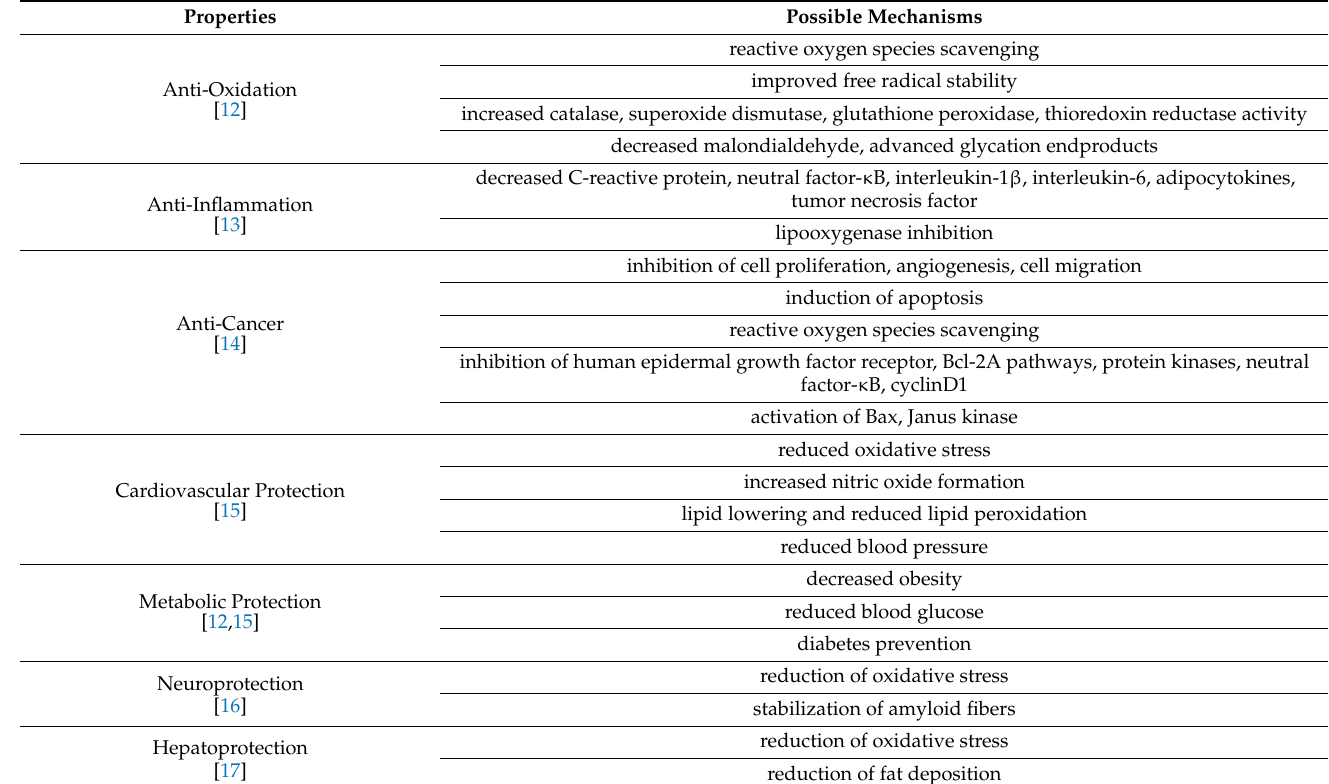
Figure 1. Effects of oleuropein on glucose homeostasis and the related mechanisms. Table 1. Biological properties and effects of oleuropein.